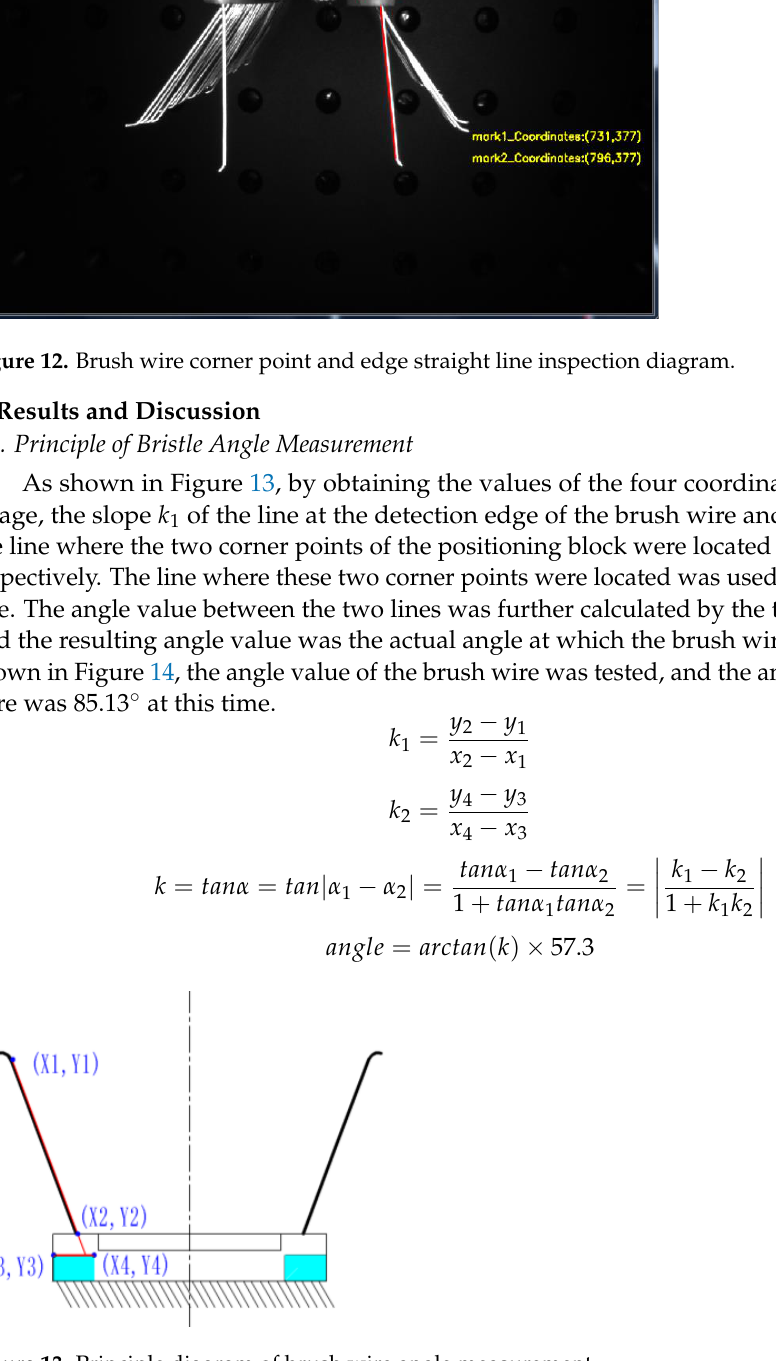
Figure 13. Principle diagram of brush wire angle measurement.